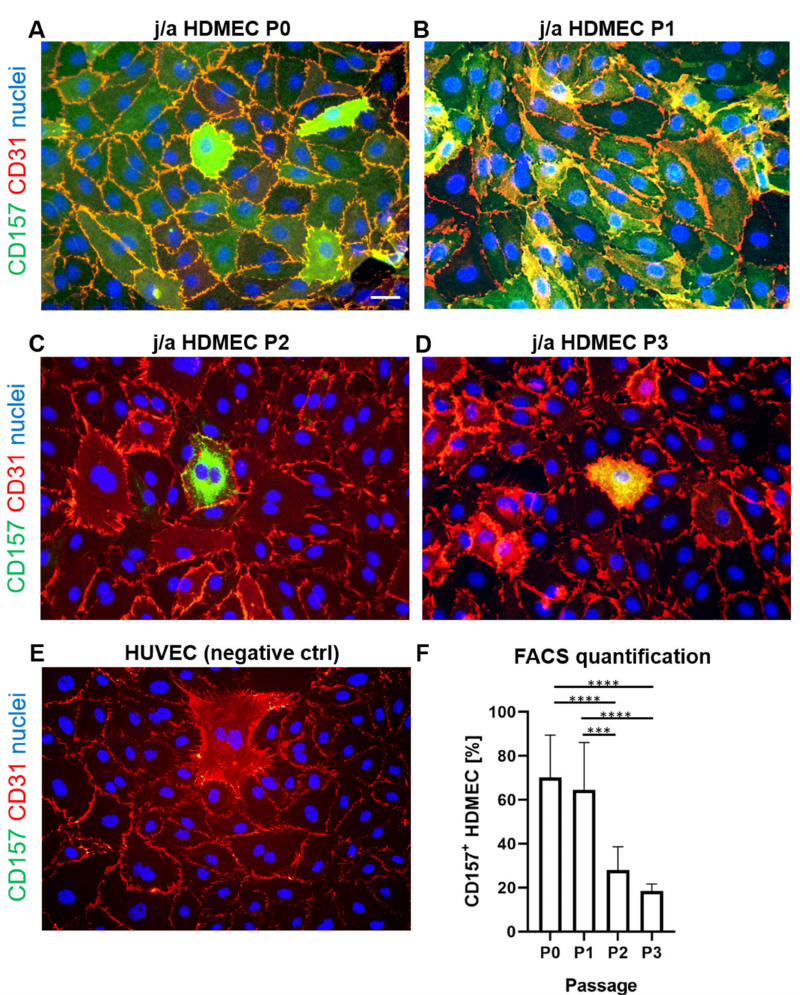
Figure 3. Expression profile of CD157 on cultured endothelial cells in vitro ( A – E ) HDMEC cul- tured at passages 0 ( A ), 1 ( B ), 2 ( C ), and 3 ( D ) were stained for CD31 (red), CD157 (green), and counterstained for Hoechst (blue). HUVEC ( E ) were used as negative control. ( F ) A quantification using cell expression measured by flow cytometry, showed a similar high expression of CD157 with 69.2 ± 23.7% expressing cells at P0 and 64.5 ± 21.6% at P1; p = 0.96, ns). Further, strong decrease in CD157 expression levels was observed at P2 in vitro (27.9 ± 10.8% vs. P0; **** p < 0.0001 extremely significant), and at P3 (18.5 ± 3.2% vs. P0; **** p < 0.0001 extremely significant) (n = 10). *** p <